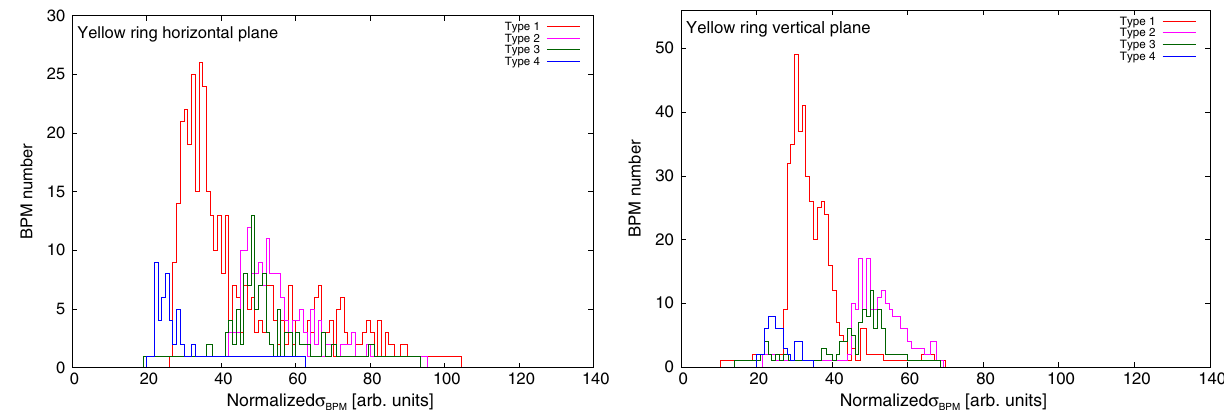
FIG. 7. Histograms of normalized noise in the horizontal (left) and vertical (right) BPMs for all cases in Fig.